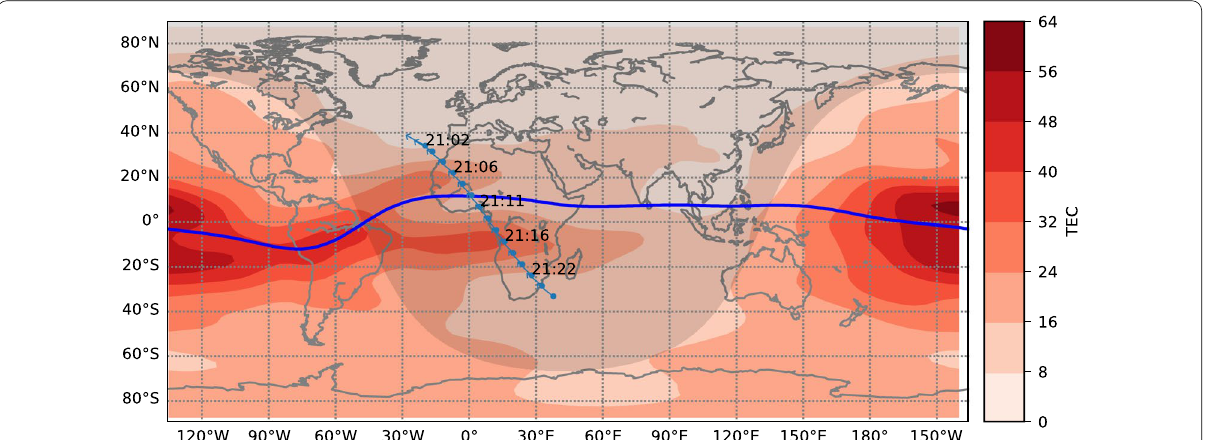
Fig. 2 Position of the ISS for the period from 21:02 UT to 21:25 UT on December 26, 2012. The tip of an arrow indicates the tangential point at each time. The blue solid line on the map indicates the dip equator. The TEC value is shown with the color contour